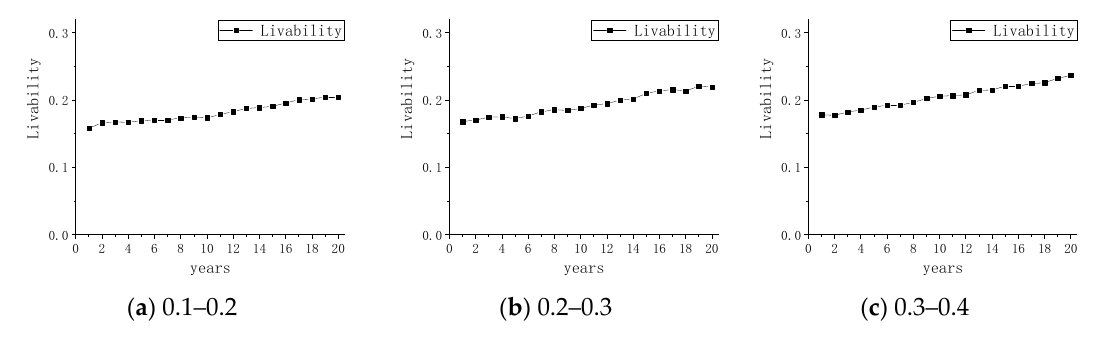
Figure 14. Safety livability with increased coverage of safety facilities.